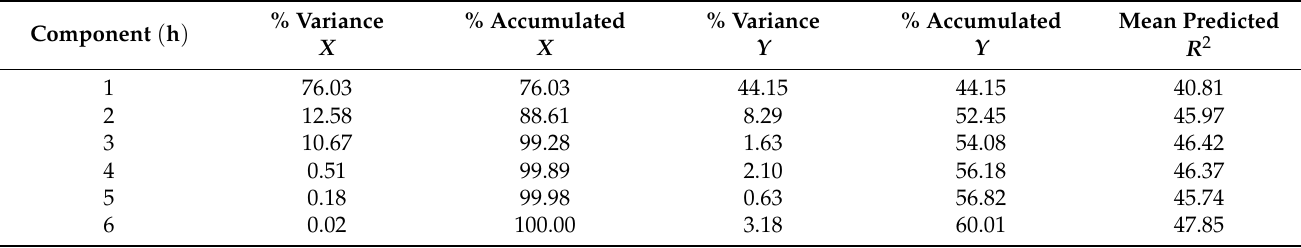
Table 5. Capability of explanatory ( X ) and response variables ( Y ) of VBT, VT, VR and VO associations to capture % of variance depending on the number of components. Predictive potential expressed as R 2